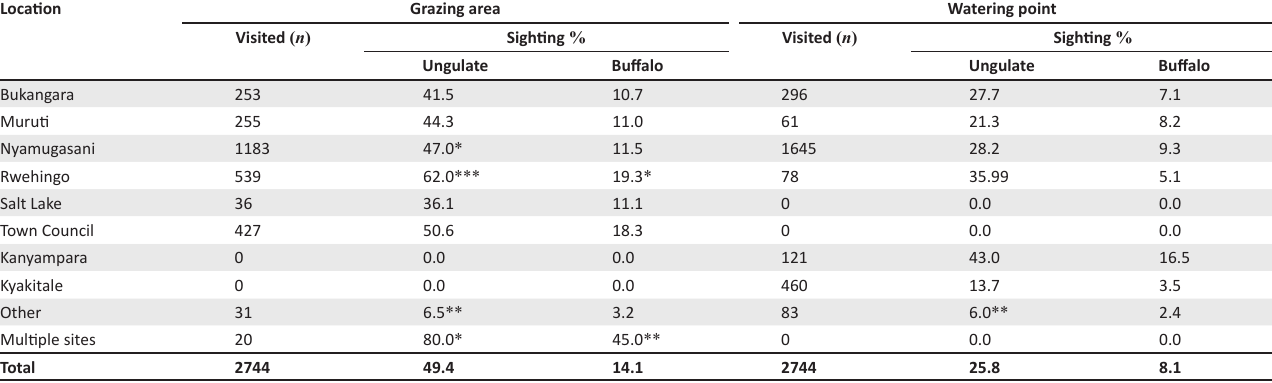
TABLE 4: Grazing and watering locations showing the area visited and the percentage of ungulate and buffalo sightings at each location. Location